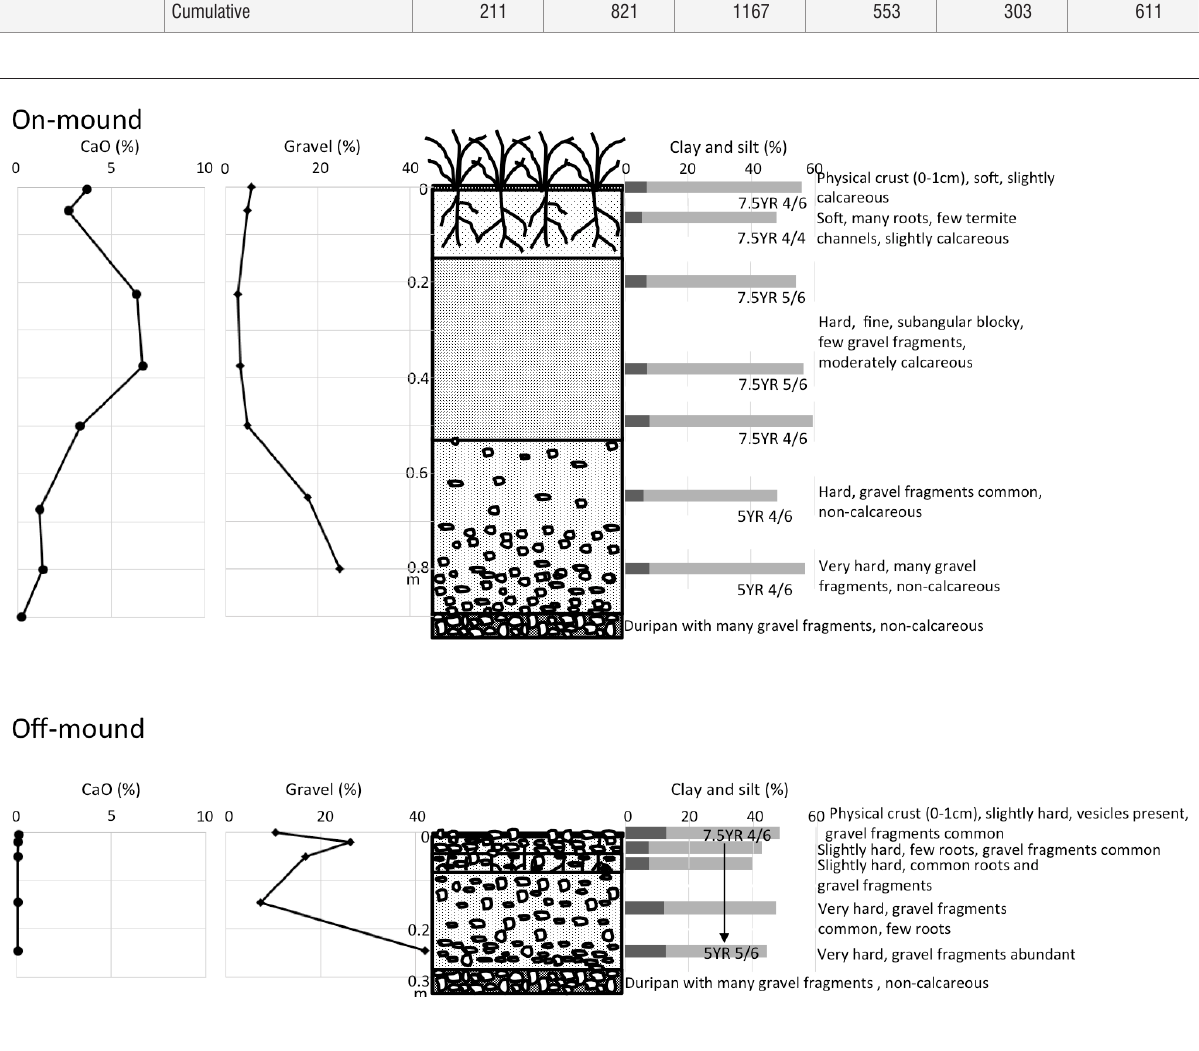
Figure 3: On- and off-mound profiles with CaO (%) of fines, proportion of gravel (% by mass) and proportion of clay and silt of < 1 mm fraction (% by volume). Horizon boundaries are gradual in most instances, but are illustrated here as abrupt for clarity. Gravel fragments and roots are not drawn to